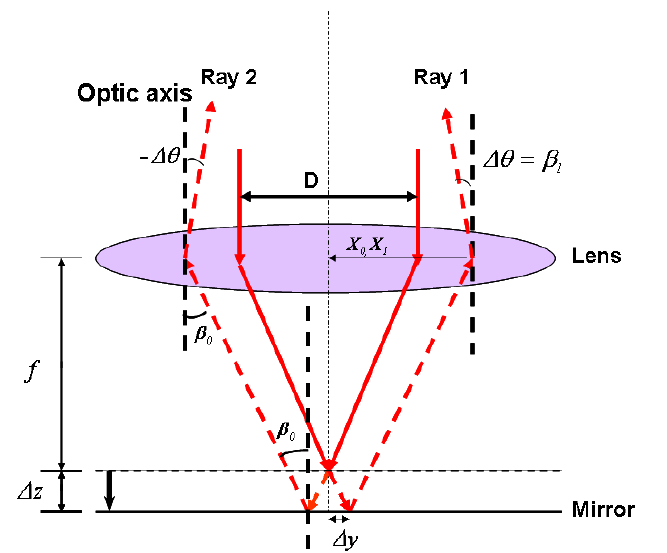
Figure 3. Rays back from the DP ( f : the focal length of an objective lens, D : the diameter of the beam, Δθ : the angular deviation from optic-axis, β incident on the mirror, Δ z : the displacement of the mirror, Δ y : the distance off the optical axis if Δ z exits)